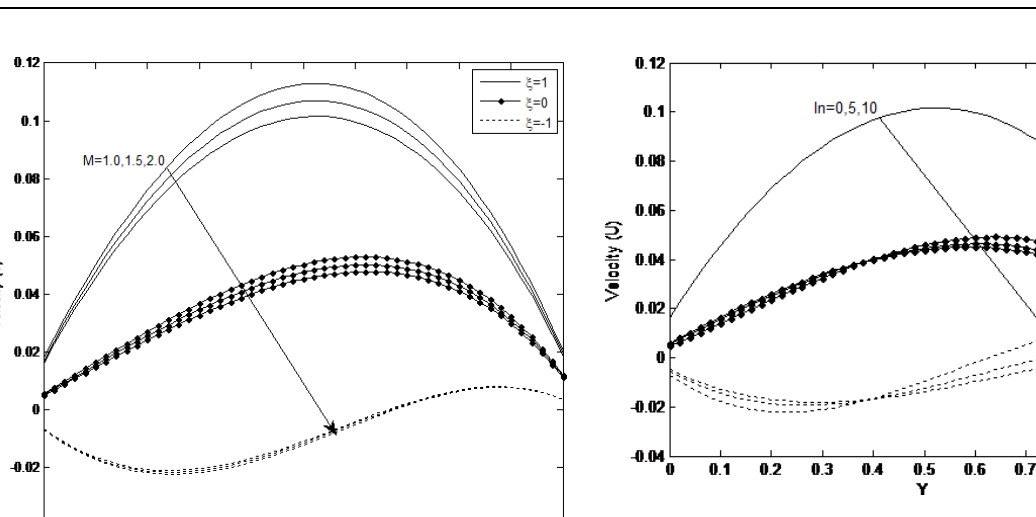
Fig. 6: Effect of fluid wall interaction parameter on velocity profile